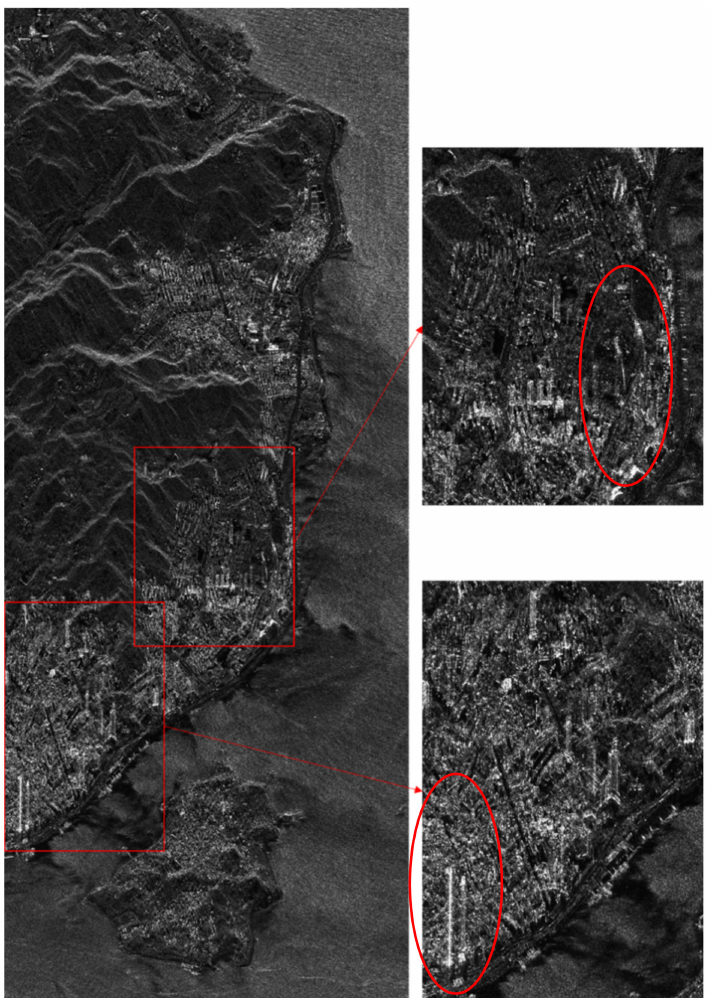
Figure 3. One-meter resolution spotlight-mode SAR image of Xiamen University Siming Campus, the gridding size is 1937 × 4750 (horizontal × vertical). The left red rectangle border indicates the high-rise area, which shows some 3D features of buildings. The right red rectangle indicates the main part of the campus. The oval borders indicate the high rises’